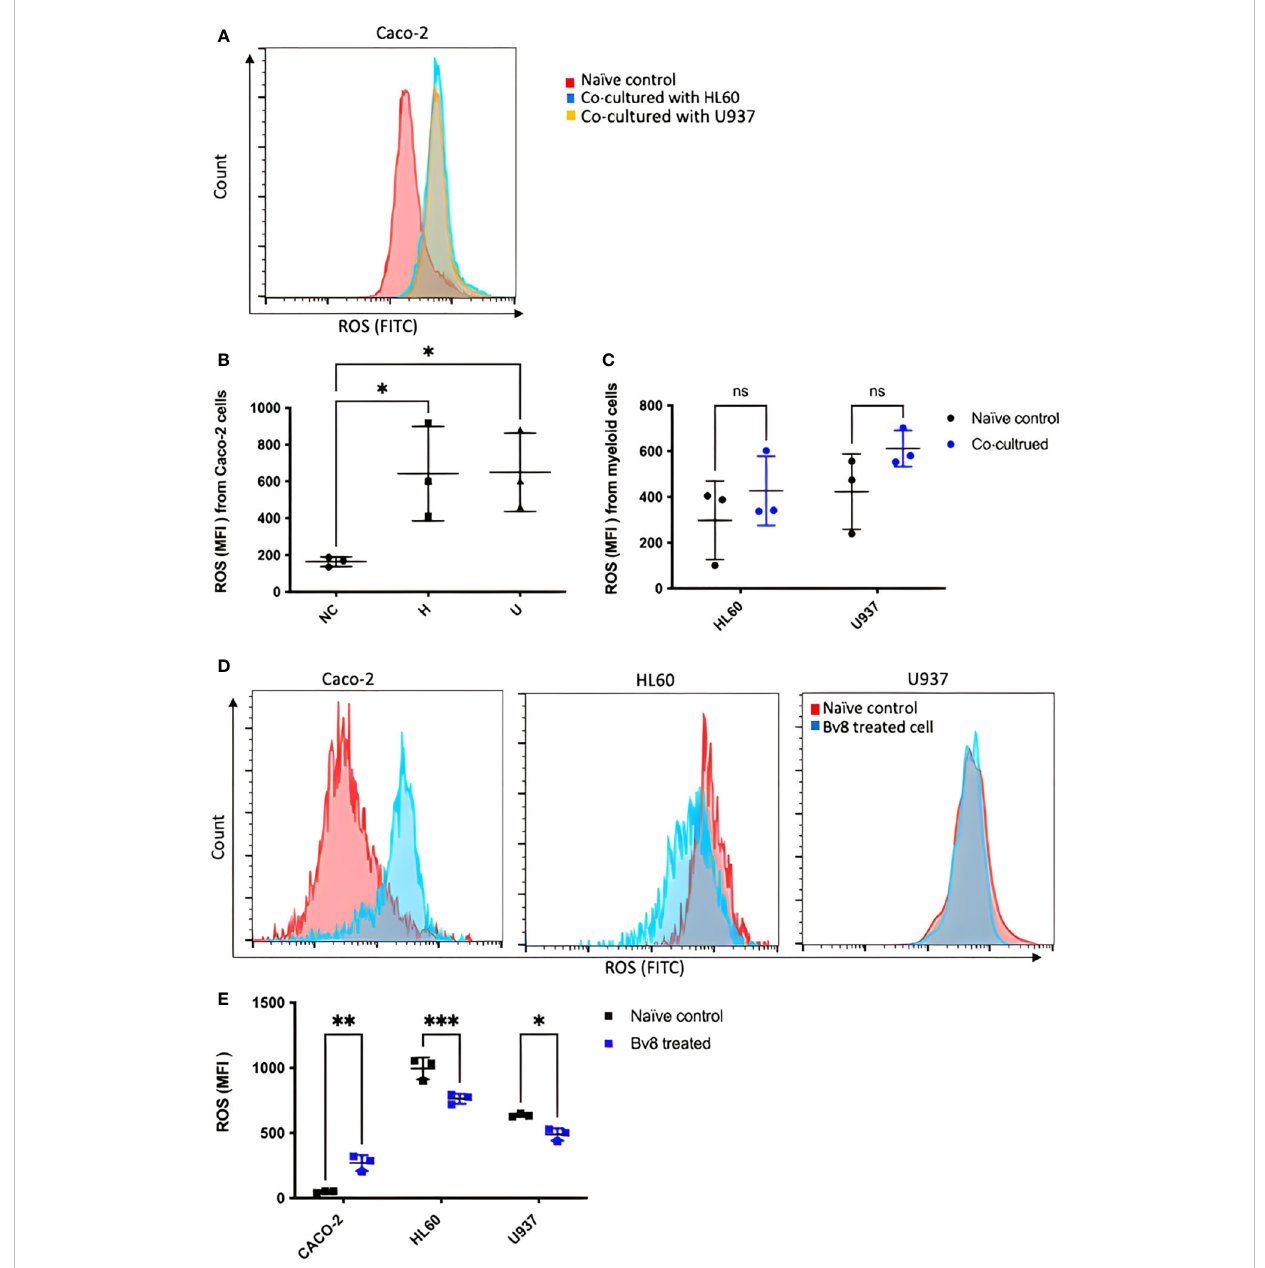
FIGURE 5 ROS production from CRC cells and myeloid cells after co-culture or Bv8 treatment. ROS production from both CRC cells and myeloid cells after 24-hour co-culture was assessed by fl ow cytometry. (A) The histogram of fl uorescent intensity of ROS from Caco-2 cells, where the peak of treatment curve shifted to the right (blue: Caco-2 cells co-cultured with HL60, yellow: Caco-2 cells co-cultured with U937) compared to naïve control (red). (B) Co-culturing with HL60 cells and U937 cells signi fi cantly enhanced ROS production from Caco-2 cells (n=3). (C) No signi fi cant change of ROS production from either HL60 cells or U937 cells was observed after co-culturing with Caco-2 cells (n=3). (D) Histograms showed right-shift of ROS fl uorescent intensity in Caco-2 cells and left-shift in HL60 cells and U937 cells (red: naïve control, blue: Bv8 treated cells). (E) Increased ROS in Caco-2 cells and decreased ROS level in HL60 cells and U937 cells after treated with 1 nM Bv8 for 24 hours (n=3). All data were presented as mean ± SD. Mann-Whitney U test followed by Dunn ’ s test was used for statistical analysis. *p<0.05, **p<0.01, ***p<0.001, ns, not signi fi cant, NC, naïve control; H, Caco-2 cells that were co-cultured with HL60 cells; U, Caco-2 cells that were co-cultured with U937 cells. n refers to the number of independent